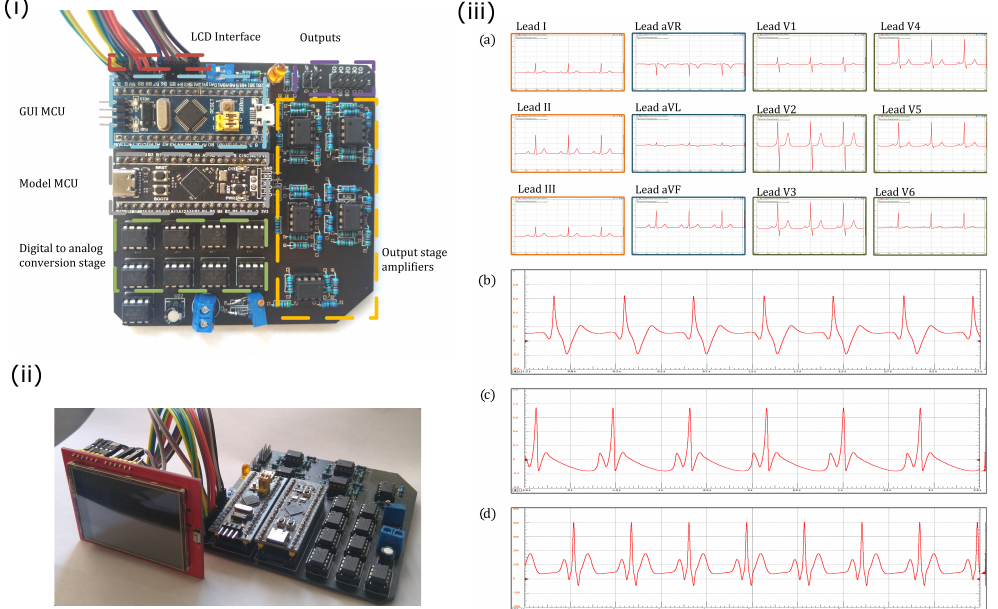
Figure 3. ( i ) Electronic circuit of the proposed ECG patient simulator. ( ii ) Electronic circuit including the TFT LCD touch screen. ( iii ) Normal synthetic ECG waveforms obtained from the ECG patient simulator for different mathematical models: ( a ) network of heterogeneous oscillators (3), ( b ) dis- cretized reaction–diffusion model (5), ( c ) ring of three coupled oscillators (7), and ( d ) model based on a quasiperiodic motion